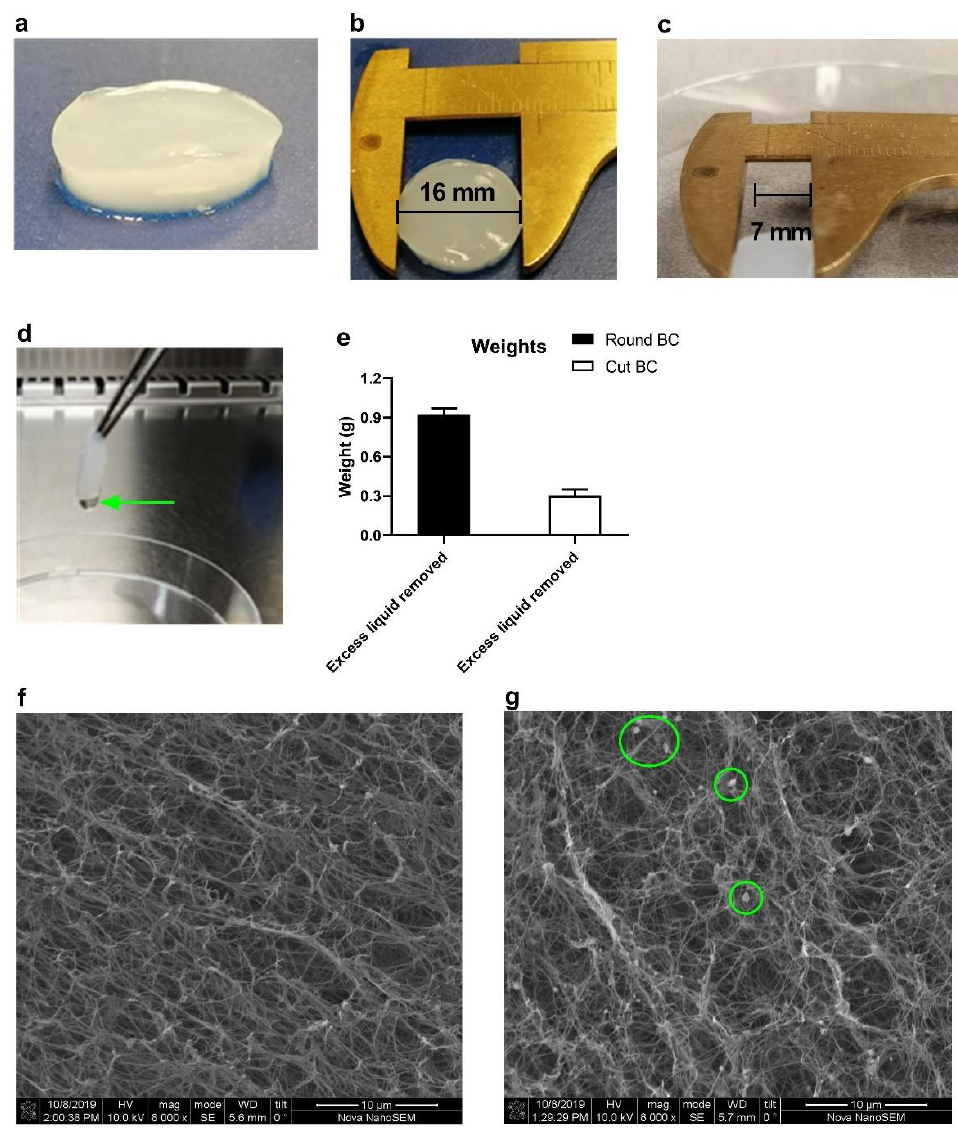
Figure 1. Characteristics and morphology of bacterial-derived cellulose (BC). ( a , b ) The photographs show the appearance of a freshly produced (native) BC fleece (referred to as round BC), which has the shape and size of the wells of a 24-wells culture dish. Image ( c ) shows a fleece of which the edges were cut (cut BC). Excess liquid droplets were removed by holding the BC fleece with forceps ( d ), and afterward, the fleeces were weighted ( e ). Figures ( f , g ) represent representative SEM images for native and IgG-loaded BC, respectively. Data in ( e ) are shown as mean ± SD for triplicate measure- ments.